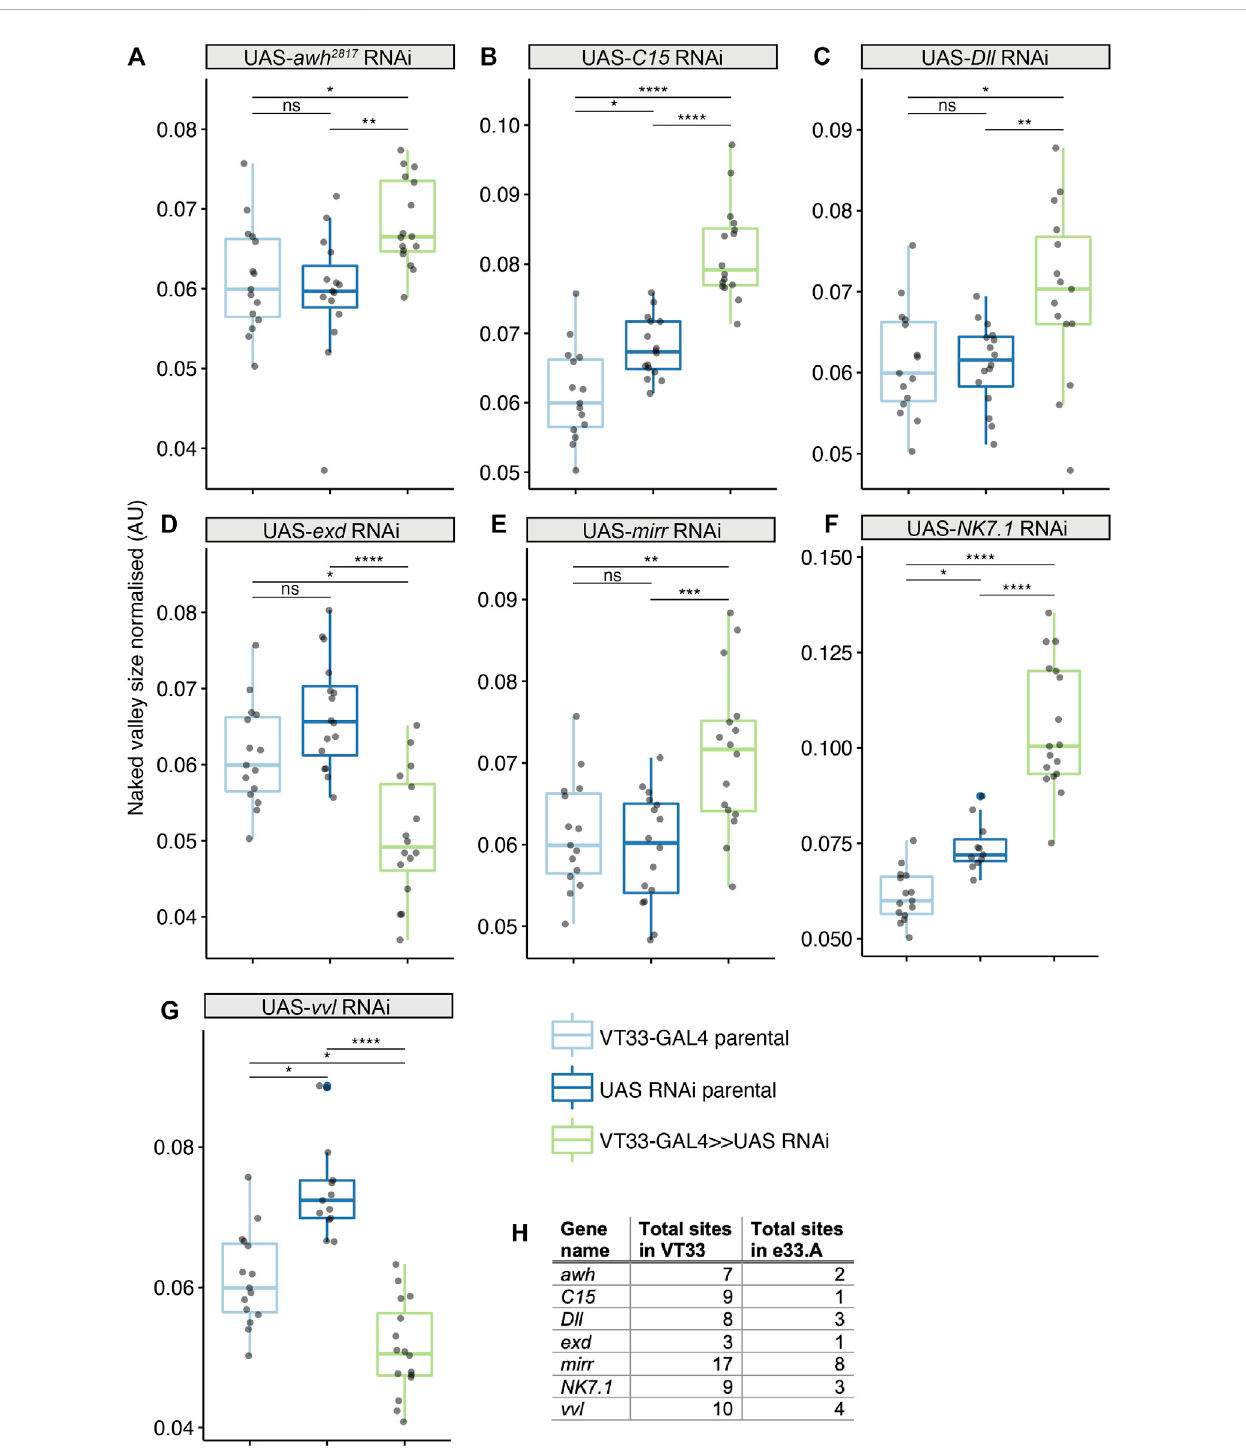
FIGURE 4 Transcriptionfactorspredictedto bindthe Ubx legenhancerthatsigni fi cantlyaffectT2trichomepatterning.Knockdownof awh (A) , C15 (B) , Dll (C) , mirr (E) and NK7.1 (F) results in a signi fi cant increase in the size of the NV, while exd (D) and vvl (G) knockdown makes the NV smaller. In each case the progeny from the cross betweentheUAS-RNAiandtheVT33-GAL4(greenboxes)werecomparedtotheparentalstrains(blueboxes).Signi fi cancelevelsareshownabovethepairs, p -values ( p > 0.05NS, p ≤ 0.05*, p ≤ 0.01**, p ≤ 0.001***, p ≤ 0.0001****)werecalculatedwithanANOVAorKruskal – Wallisdependingonnormality. (H) Summaryofthe number of binding sites found by JASPAR for the seven TFs in the whole of the VT42733 (VT33) enhancer and how many of those sites are found in e33.A.